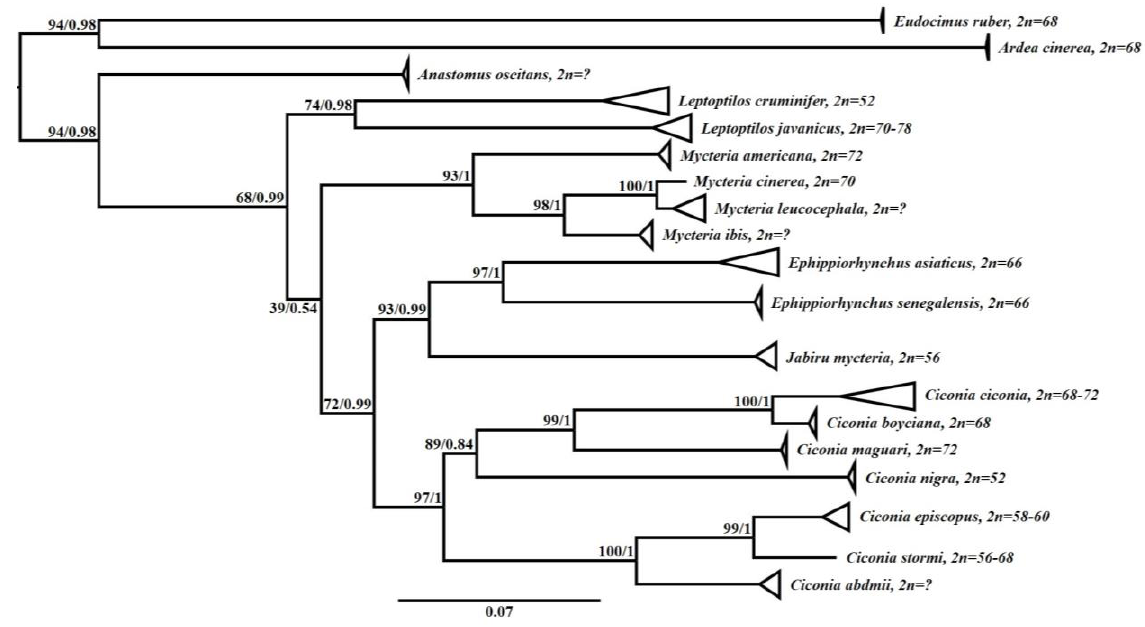
Figure 4. Phylogeny of Ciconiidae based on molecular and cytogenetic data. Node values correspond to support value (ML) and posterior probability (BI), respectively.